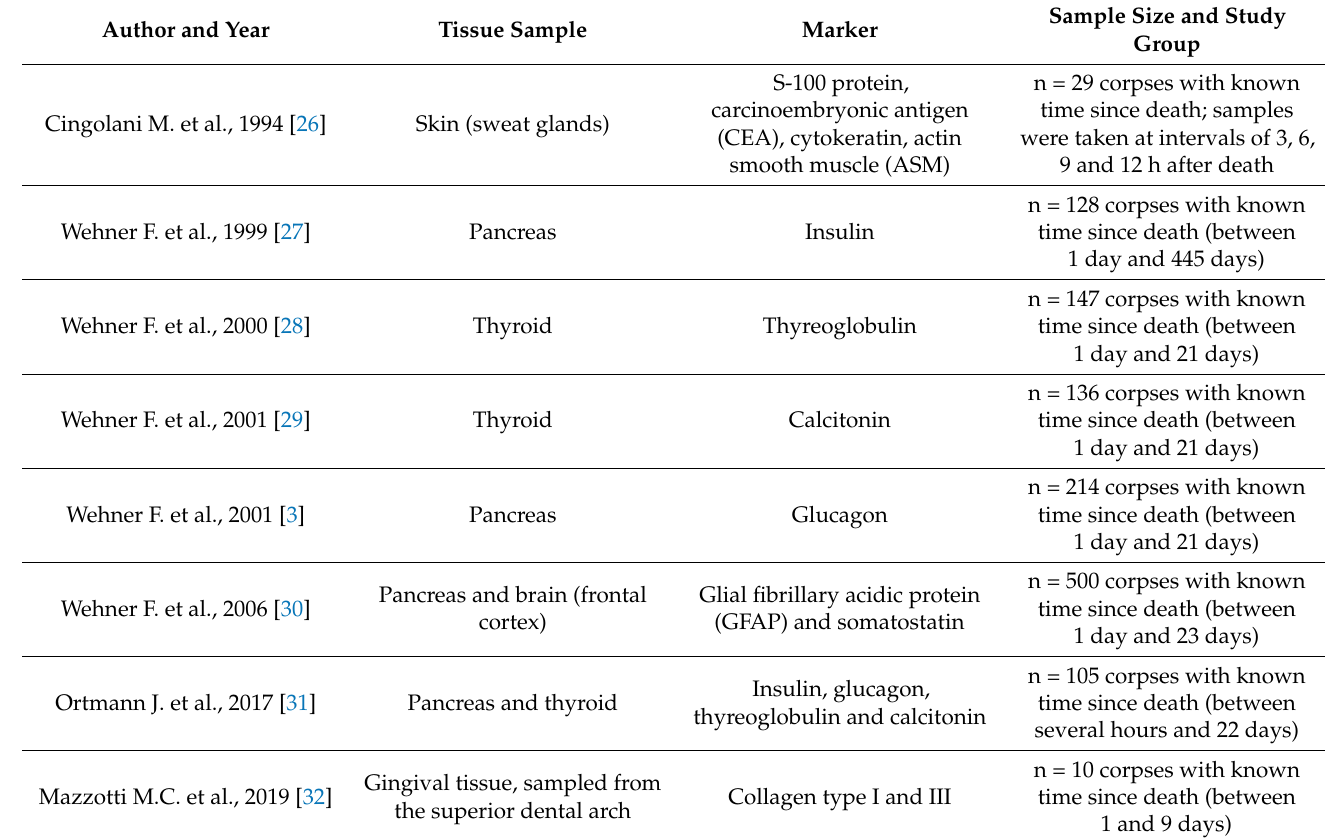
Table 6. Summary overview of study